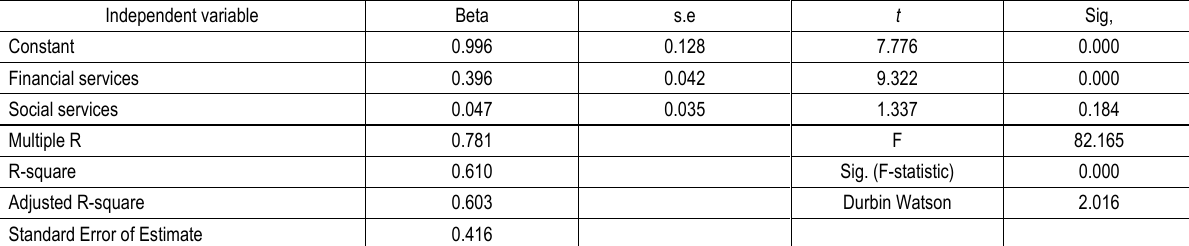
Table 4. Multiple regression of the impact of the services of microfinance banks on SMEs’